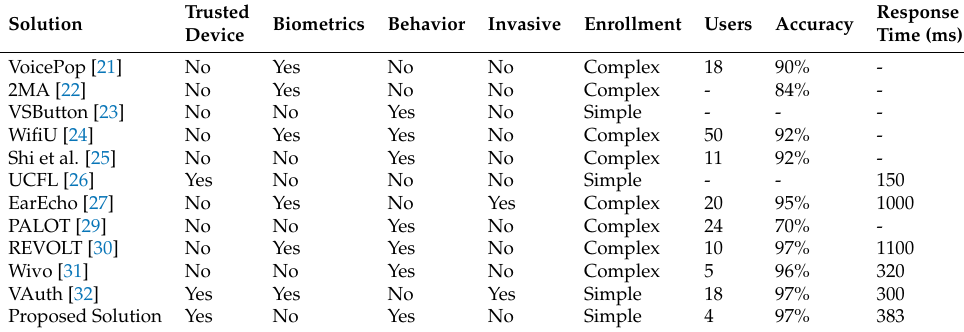
Table 3. Comparison of proposed solution with related work.